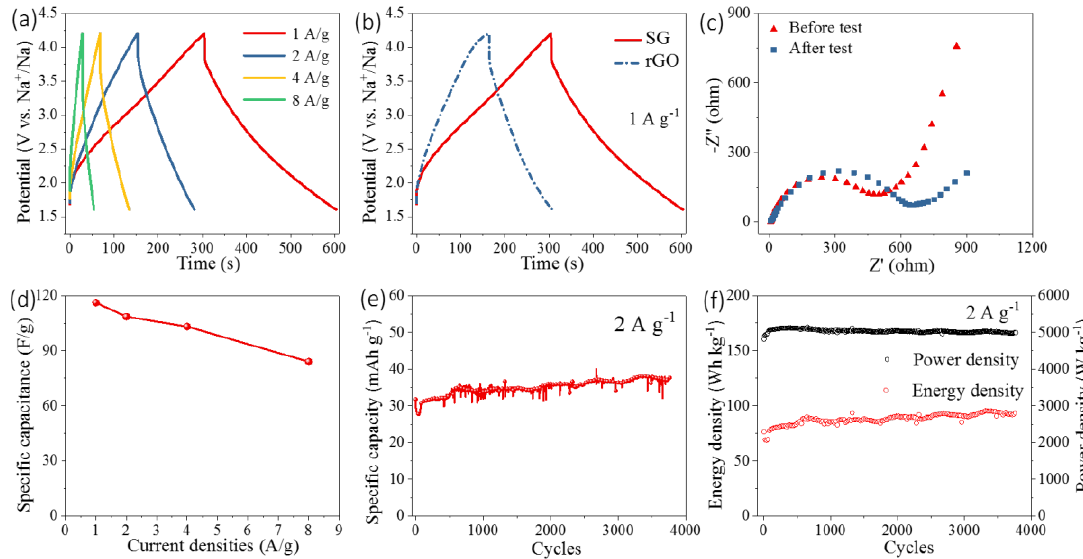
Figure 4. ( a ) Galvanostatic charge and discharge (GCD) curves of SG as the cathode of NICs ranging from 1.6 V to 4.2 V at different current densities; ( b ) comparison of the GCD curves of SG and rGO; ( c ) Nyquist plots of SG before and after electrochemical tests; ( d ) rate capacitances of SG at different current densities; and ( e,f ) Cycle performance of SG at a current density of 2 A/g.